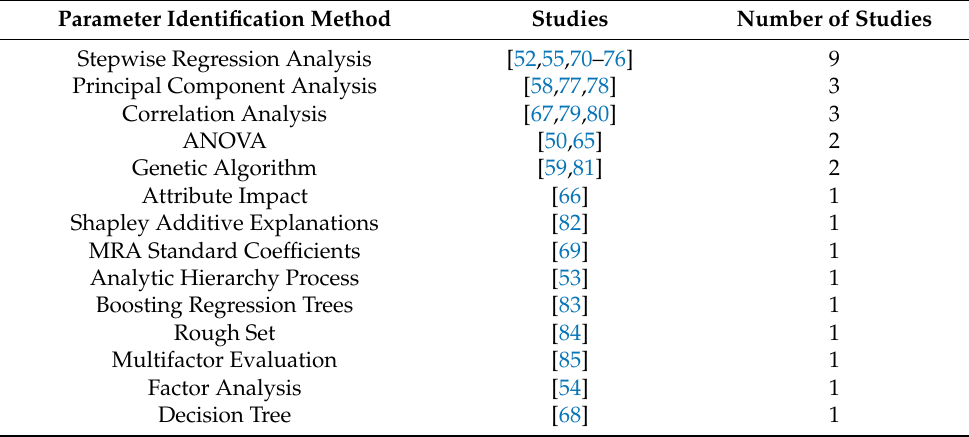
Table 3. Methods used to optimise the